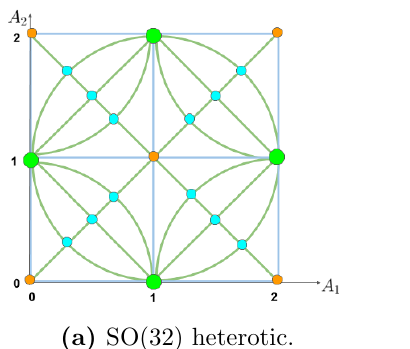
(a) SO(32) heterotic. Figure 4. Enhancement groups on the left sector of the heterotic theory on the slice of moduli space de(cid:12)ned by A 3 ;:::; 16 = 0, R 2 = 1 = 2. See table 3 for